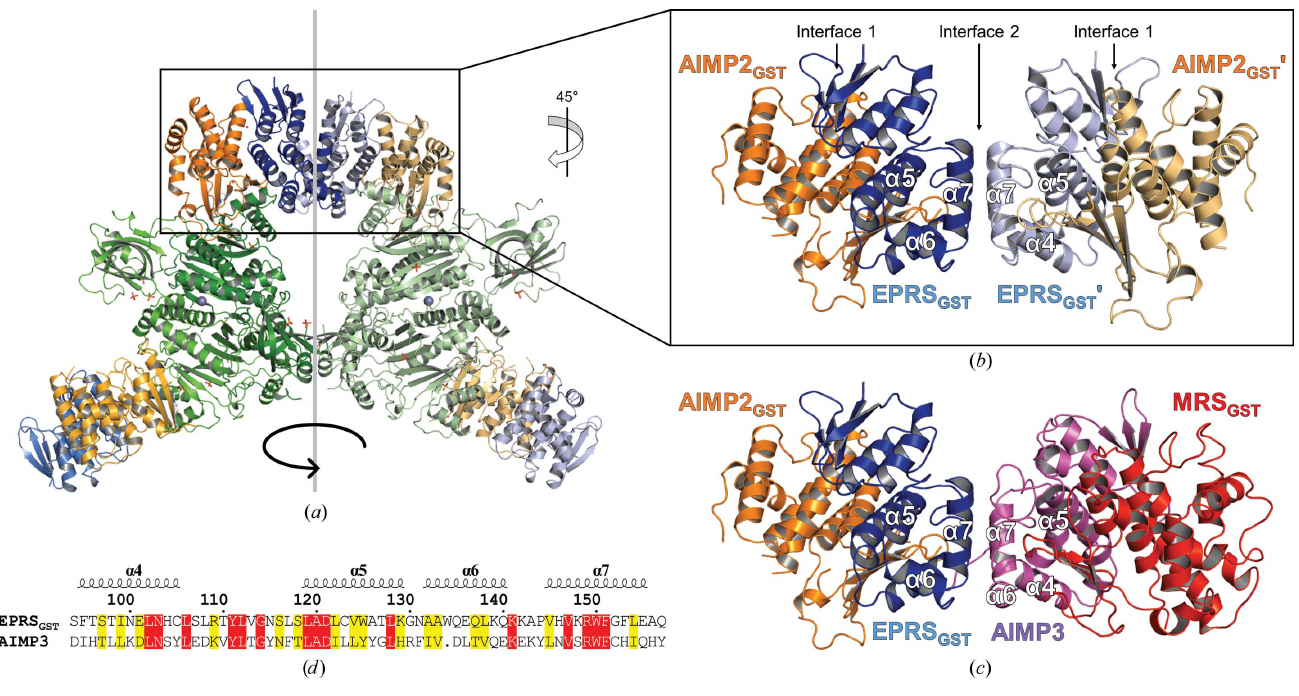
Figure 3 Interaction between GST domains via Interfaces 1 and 2. ( a ) Two DA2E subcomplexes within an asymmetric unit show an overall twofold rotational symmetry. One of the subcomplexes is shown in paler colors to distinguish the two. ( b ) Close-up view of the heterodimeric AIMP2 GST –EPRS GST complexes at the interface of the two DA2E subcomplexes. AIMP2 GST and EPRS GST interact via Interface 1, while two EPRS GST molecules from adjacent subcomplexes interact via Interface 2. ( c ) Close-up view of the model structure of heterotetrameric AIMP2 GST –EPRS GST –AIMP3–MRS GST built upon the DA2E subcomplex structure, in which AIMP3 and MRS GST are colored violet and red, respectively (PDB entry 4bvx). The assembly of the heterotetrameric GST domains is identical to that of AIMP2 GST –EPRS GST –EPRS GST –AIMP2 GST observed in our structure ( b ). ( d ) Sequence alignment of residues in Interface 2 of EPRS GST and AIMP3 using Clustal Omega (Sievers et al. , 2011) displayed with ESPript 3 (Robert & Gouet, 2014). The secondary-structure elements were defined based on the structure of EPRS GST . Conserved residues and similar residues are highlighted in red and yellow,